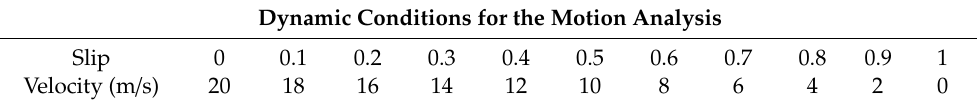
Table 4. Slips values and linear velocities simulated with FEM-3D.